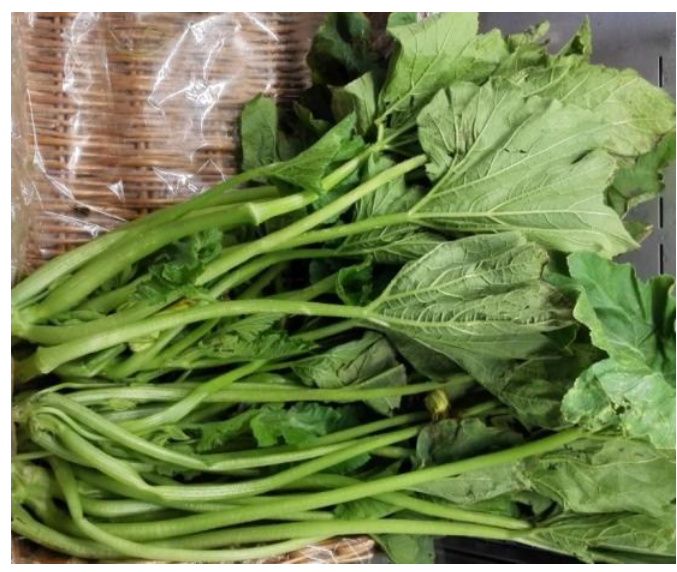
Figure 8. Summer squash greens (so-called cime di zucchini ).